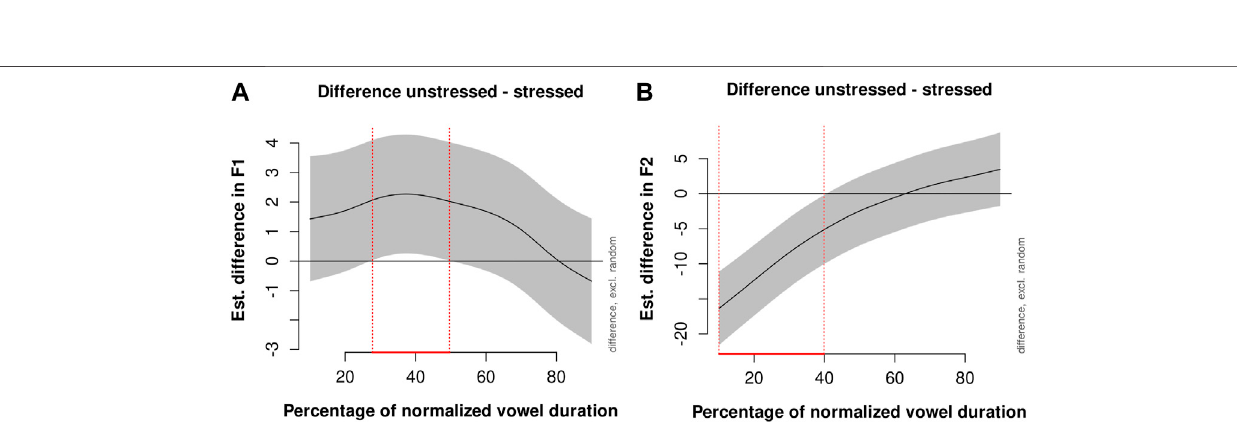
Frontiers in Communication |